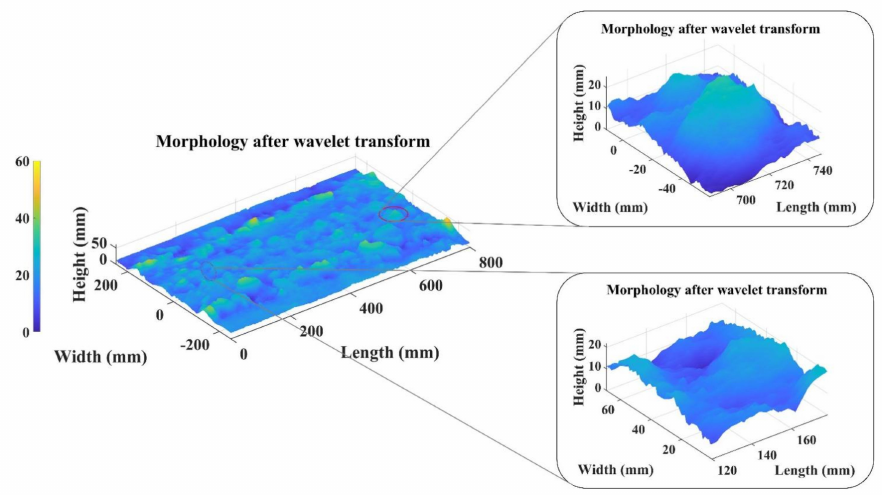
Figure 13. Concave and convex regions at the same position intercepted by the 3D digital model of the soil surface after wavelet